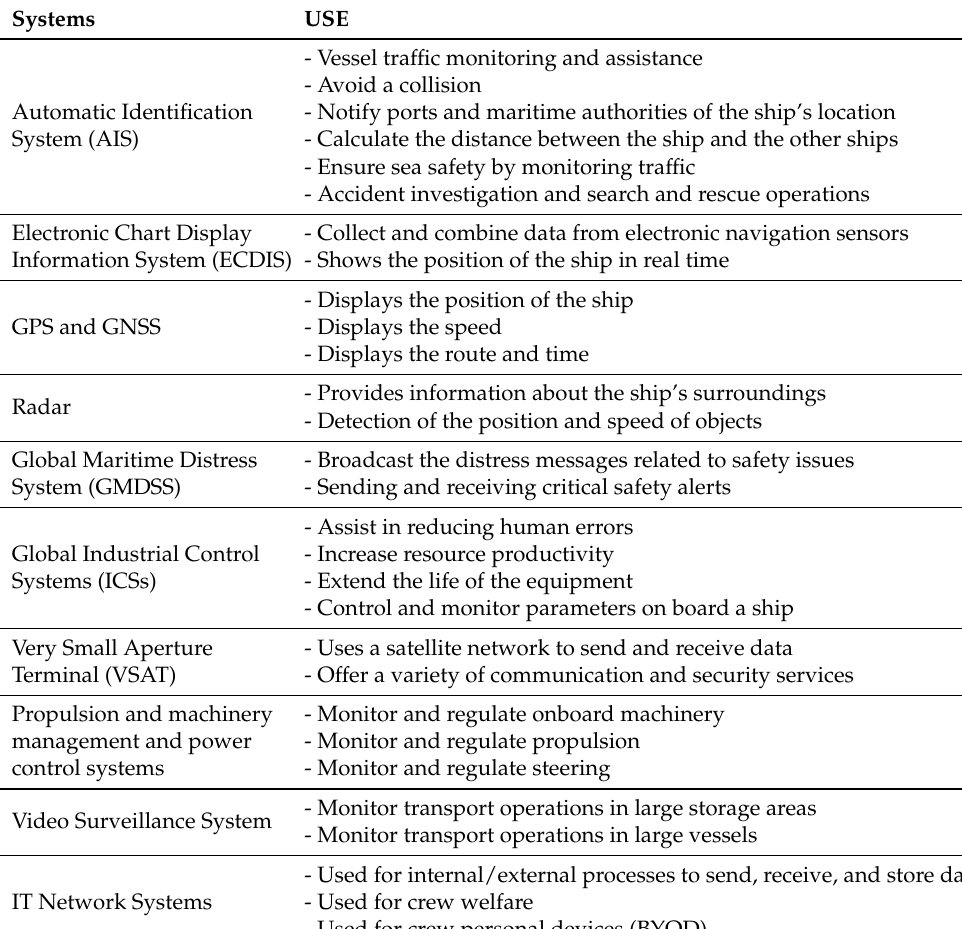
Table 1. A summary of the main automation systems in modern and autonomous